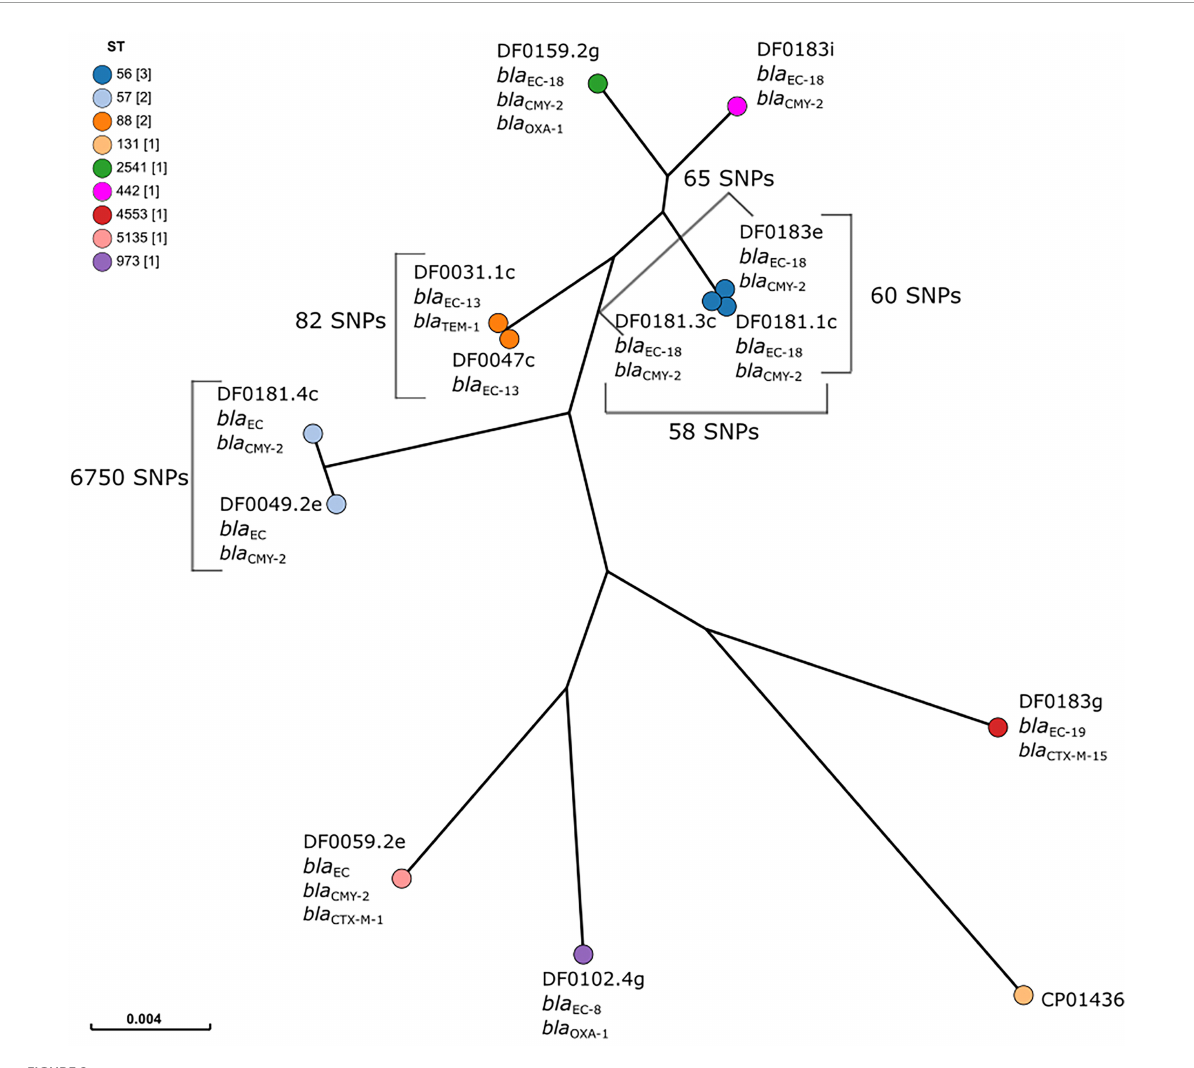
FIGURE2 Maximum-likelihood tree of core genome single nucleotide polymorphism (SNP) analysis of ESBL and AmpC-producing E. coli ( n = 12). E. coli CP014316 (ST131, bla CTX − M − 15 positive) was used as the reference and nodes are coloured by sequence type, as indicated in the figure legend. The scale bar indicates the proportion of the core genome alignment over which core SNPs have been calculated. The number of SNPs between isolates in the same cluster is indicated on the